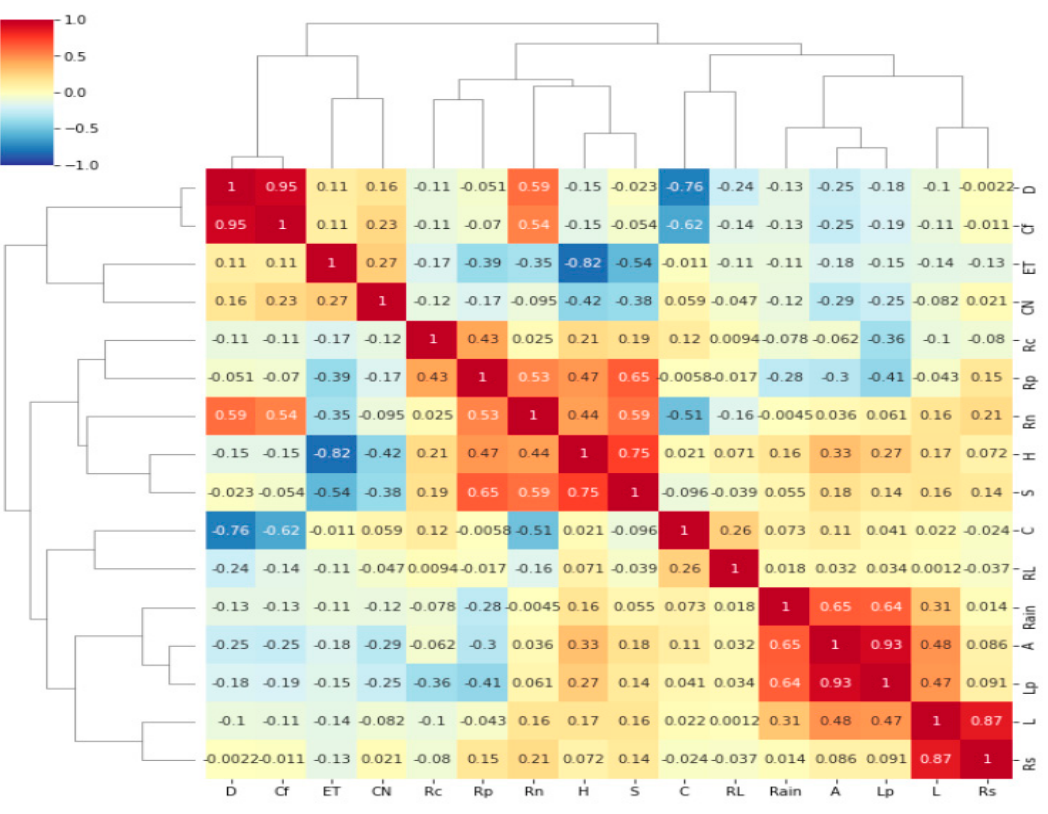
Figure 9. Variable correlation analysis.